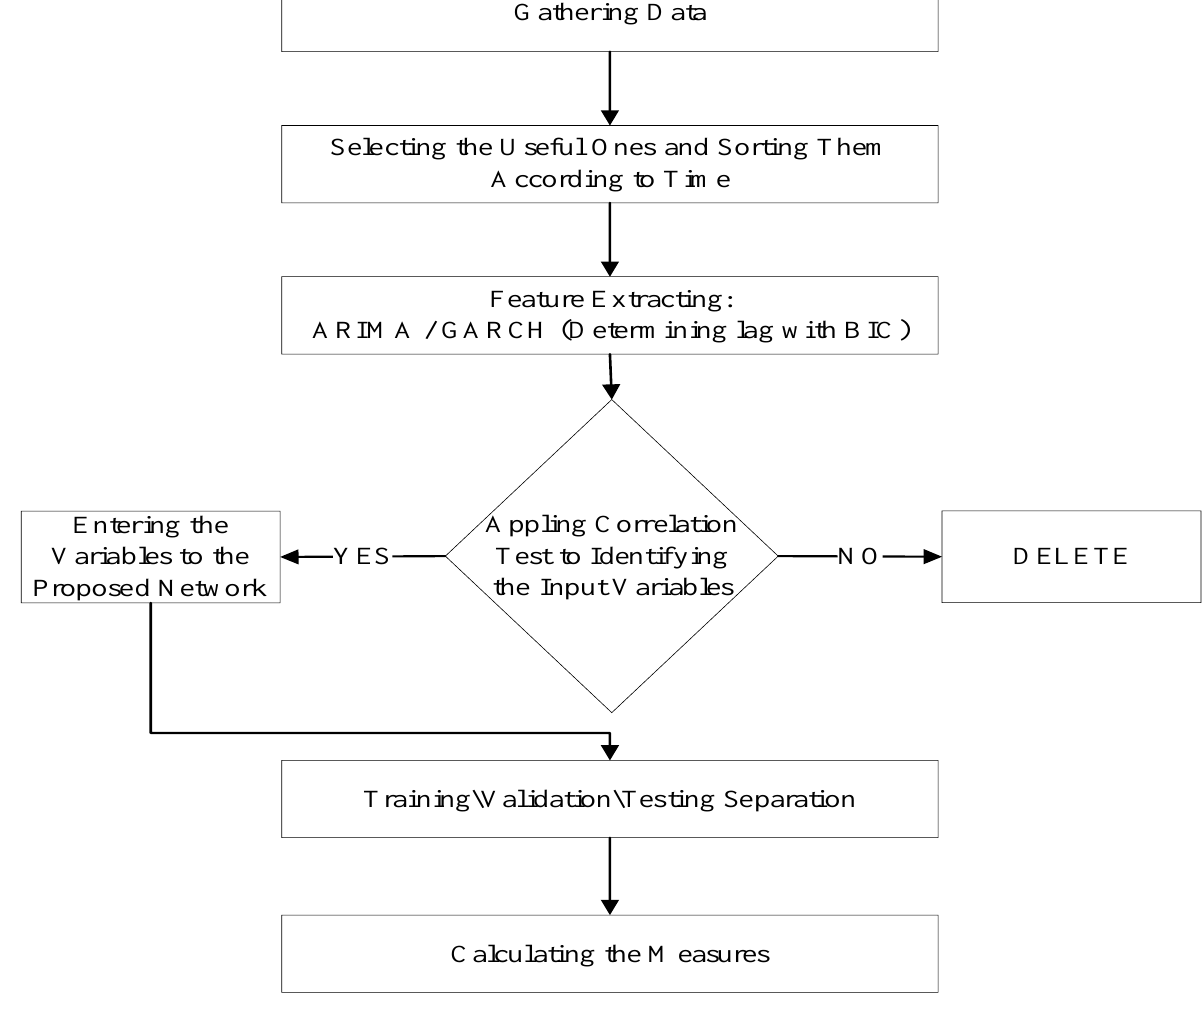
Figure 3. Flowchart of main steps.